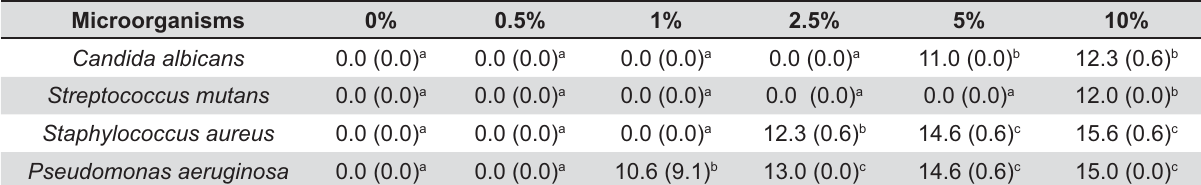
Table 1- Mean standard deviation (SD) of inhibition halos of self-cured acrylic resin incorporated with different percentages of nanostructured silver vanadate